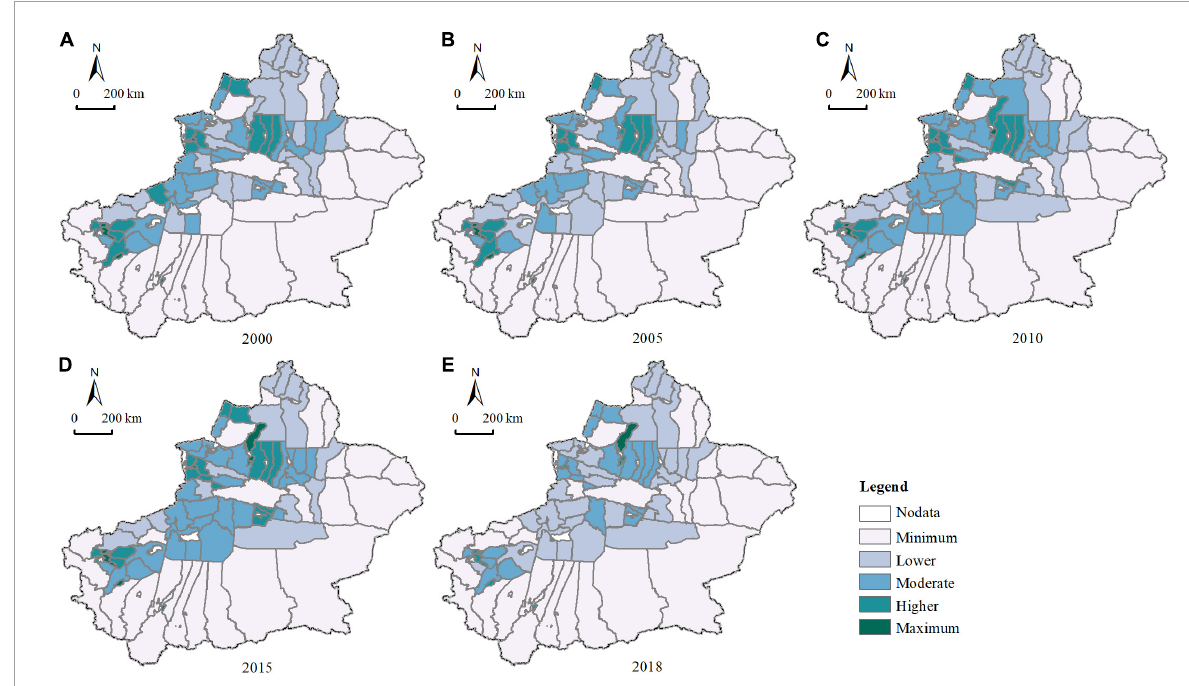
FIGURE4 Spatial distribution of farmland spatial pattern index in (A) 2000, (B) 2005, (C) 2010, (D) 2015, and (E) 2018.